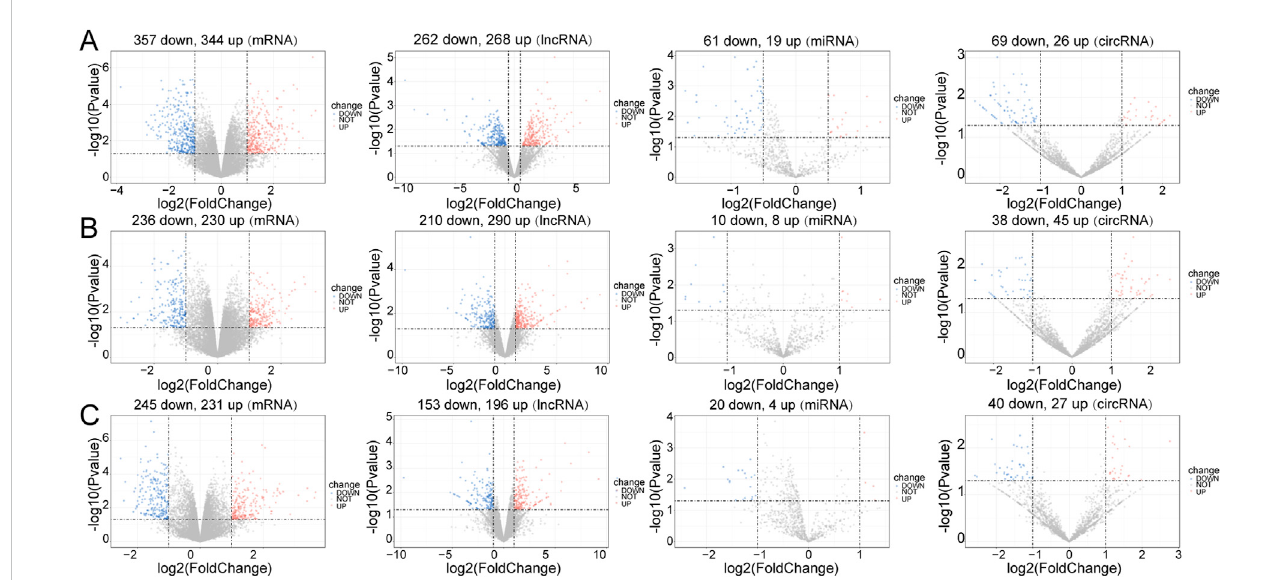
FIGURE 1 Differential expression analysis. Volcano plot for differentially expressed mRNAs (DE-mRNAs), lncRNAs (DE-lncRNAs), miRNAs (DE-miRNAs) and circRNAs (DE-circRNAs) in the three comparison groups. (A) Control vs. Case; (B) Case vs. Treatment; (C) Control vs. Treatment. Blue: downregulation, red: upregulation.